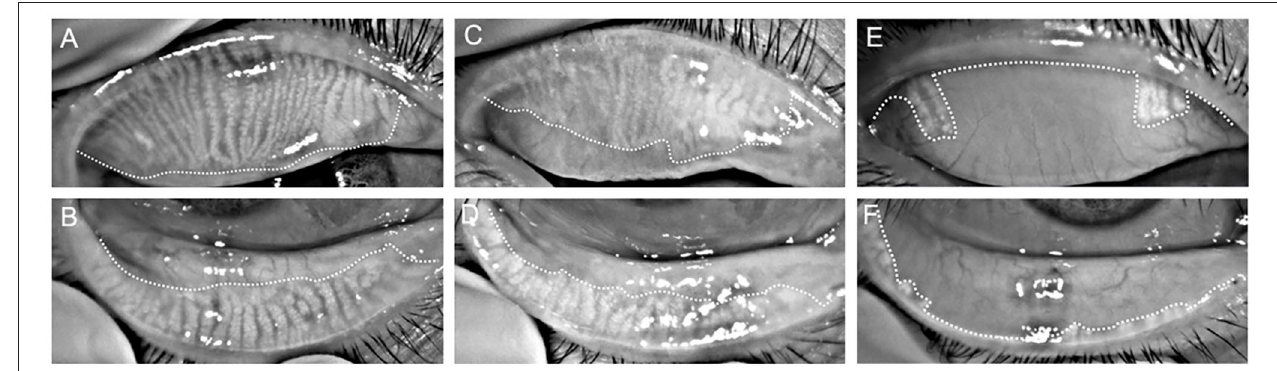
FIGURE 1 | Representative infrared meibography images from the superior (A,C,E) and inferior (B,D,F) eyelids of a control (A–D) and poor sleep (E,F) participant. Overall, the poor sleep quality participant demonstrates more extensive MG dropout than the control participant.